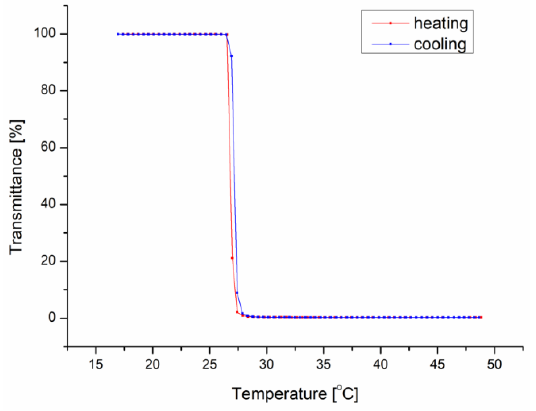
Figure 1. Sample temperature-transmittance curves for the solution obtained after the dissolution of the P(iPrOx-nPrOx) mold.